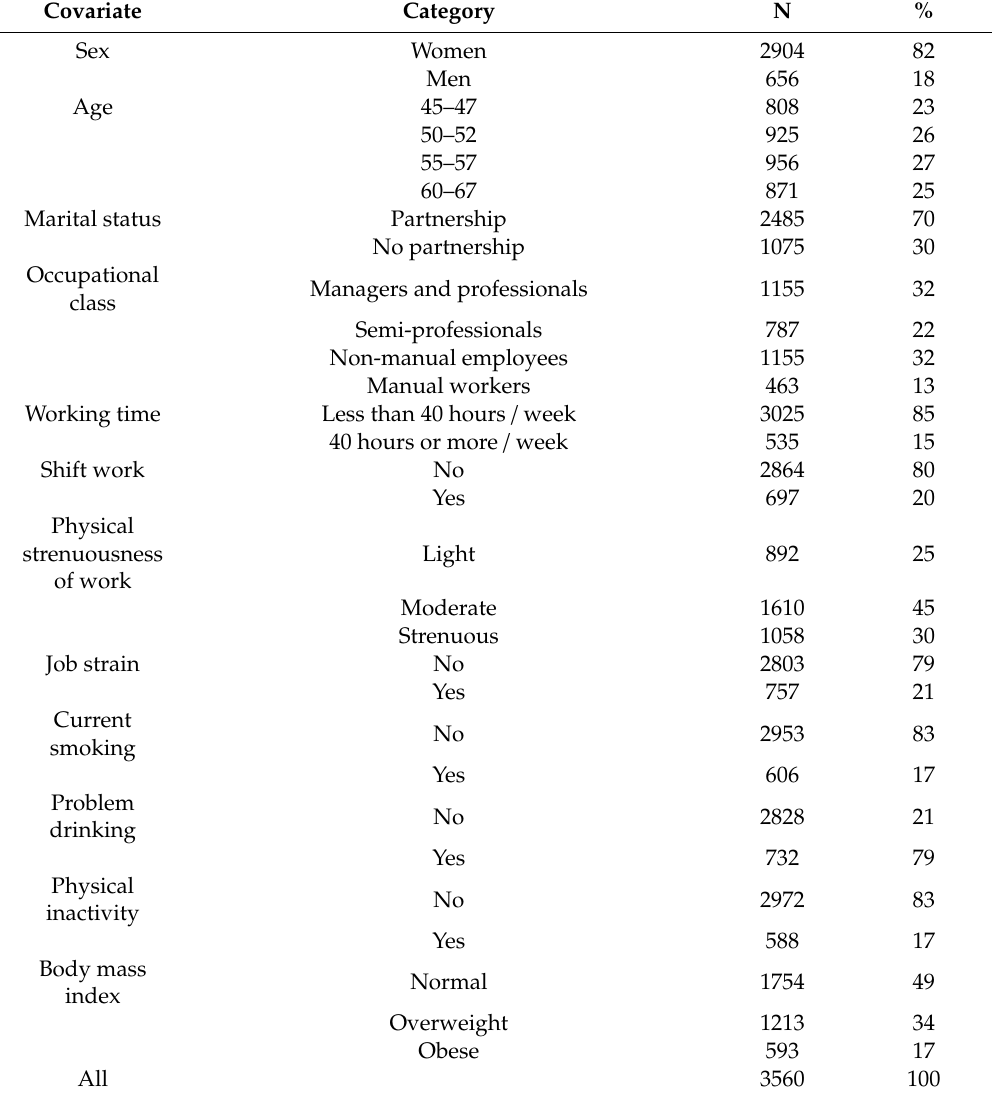
Table 1. Distribution of participants ( N , %) by